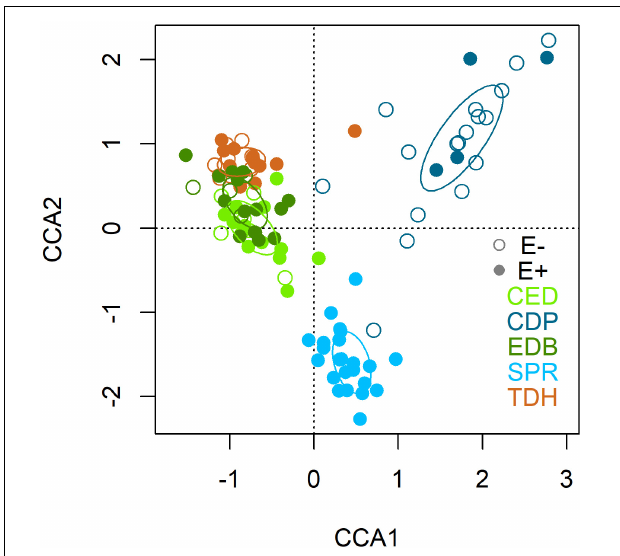
FIGURE 5 | Canonical correspondence analysis (CCA) of the fungal endophyte community composition of roots of Festuca rubra subsp. pruinosa from marine cliffs according to the presence (E+) or absence (E–) of Epichloë festucae, and population (CED, Cedeira; CDP, Cabo de Peñas; EDB, Estaca de Bares; SPR, San Pedro de la Rivera; TDH, Torre de